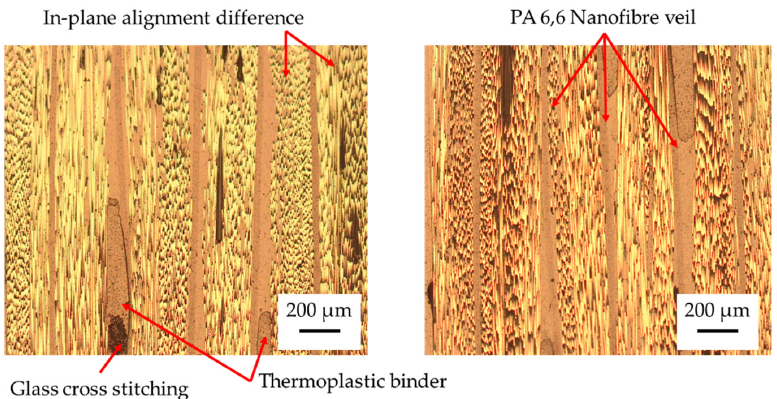
Figure 3. Optical microscopy of CFRP with veil to determine fibre alignment, void content in CFRF and GFRP.